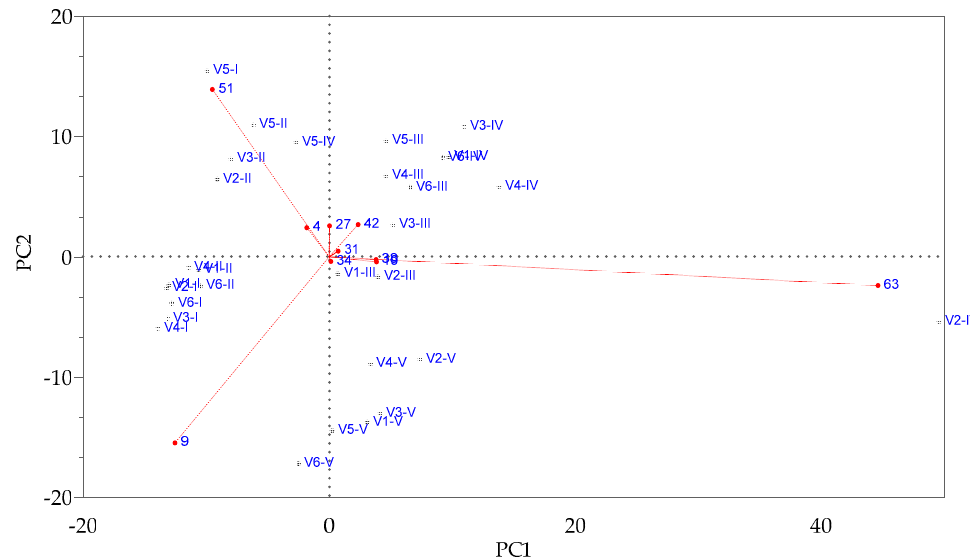
Figure 2. PCA analysis on Sauvignon blanc samples. V1—Endozym Thiol ® , AEB; V2—Endozym